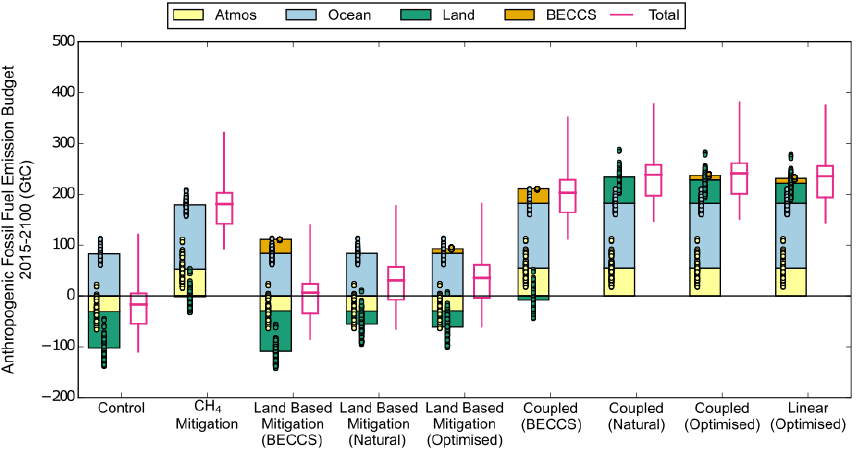
Figure 8. The contribution to the allowable anthropogenic fossil fuel emission budget (AFFEBs, GtC) from the changes in the different carbon stores (atmosphere, ocean, land, and BECCS) for the various control and mitigation scenarios, illustrated using the temperature pathways for 1.5 ◦ C of warming. The bars are the median of the component 136-member ensembles, with the individual members shown as points. The accompanying pink box and whisker plots to the right of each set of bars are for the AFFEBs (as the sum of the changes in the component carbon stores). The box and whisker plots show the median, interquartile range, minimum, and maximum derived of the resulting AFFEB ensemble. The optimised land-based and coupled mitigation options select the land use option, which maximises the AFFEB for each model grid cell. Note that the land carbon store for the CH 4 scenario at − 1 . 4GtC (median of ensemble) is not visible, although the individual ensemble members can be seen as the green